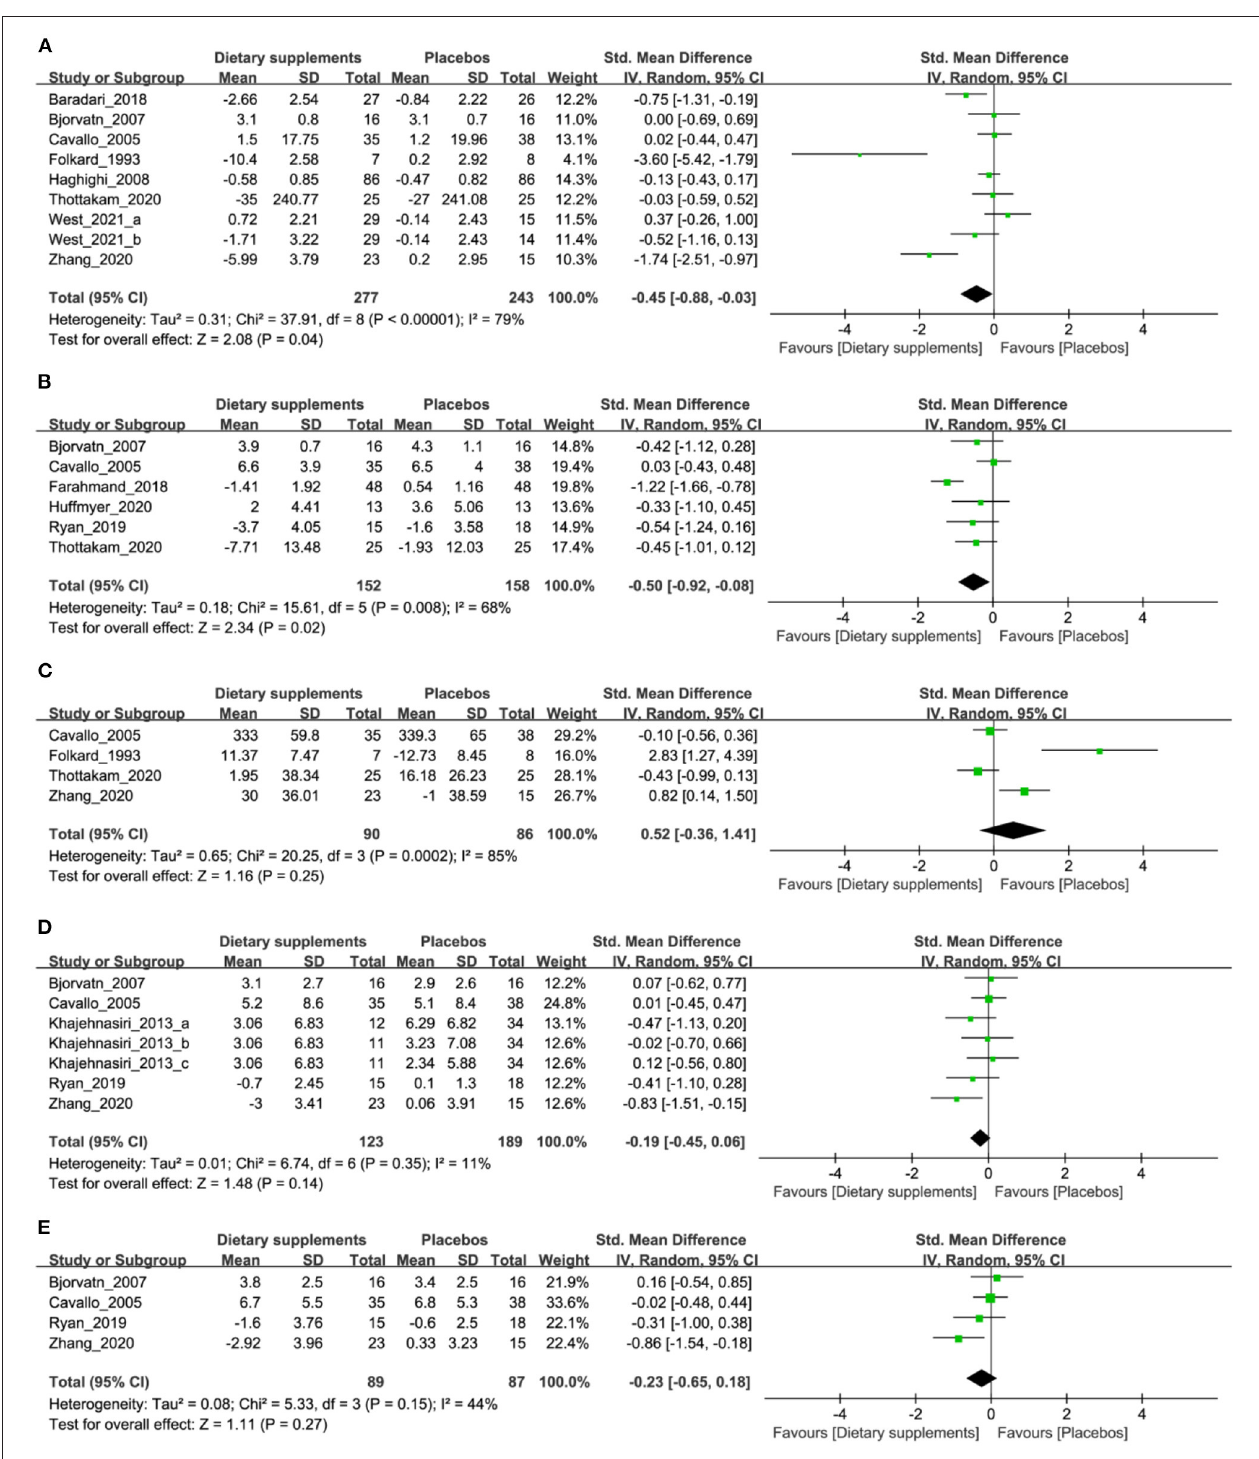
FIGURE 3 | The forest plots illustrate the meta-analysis findings of the outcomes of dietary supplements (DSs) vs. those of the placebos for shift workers. The outcomes analyzed were (A) sleep quality, (B) daytime function, (C) psychomotor vigilance, (D) depression, and (E) anxiety.